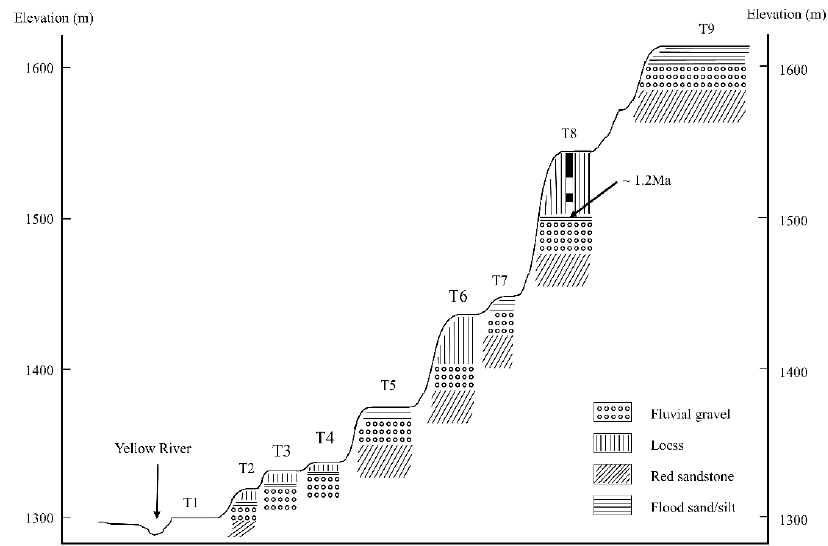
Figure 8. The composite Yellow River terrace sequence in the Wufo Basin.